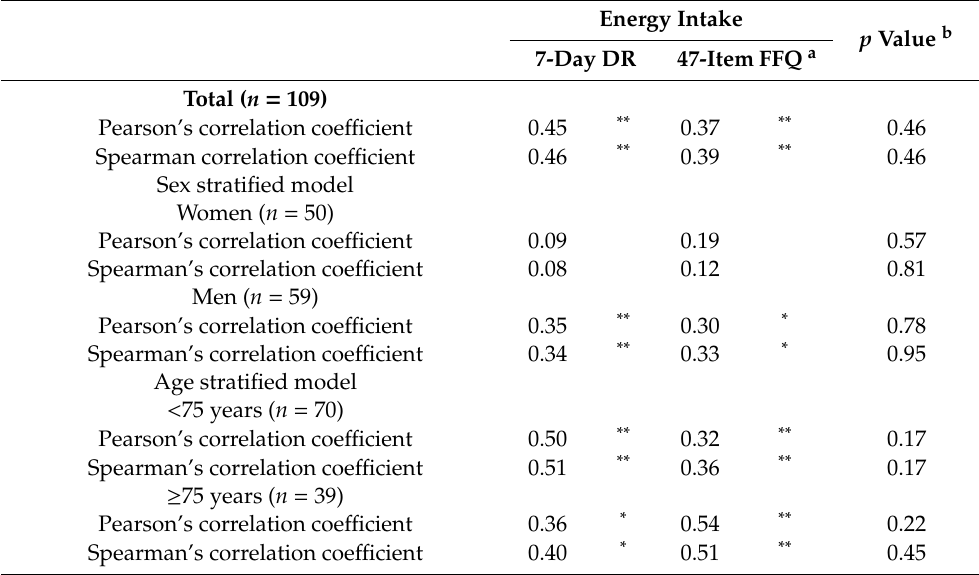
Table 3. Correlation coe ffi cients of total energy expenditure measured by doubly labeled water and energy intake assessed with dietary record and a food frequency